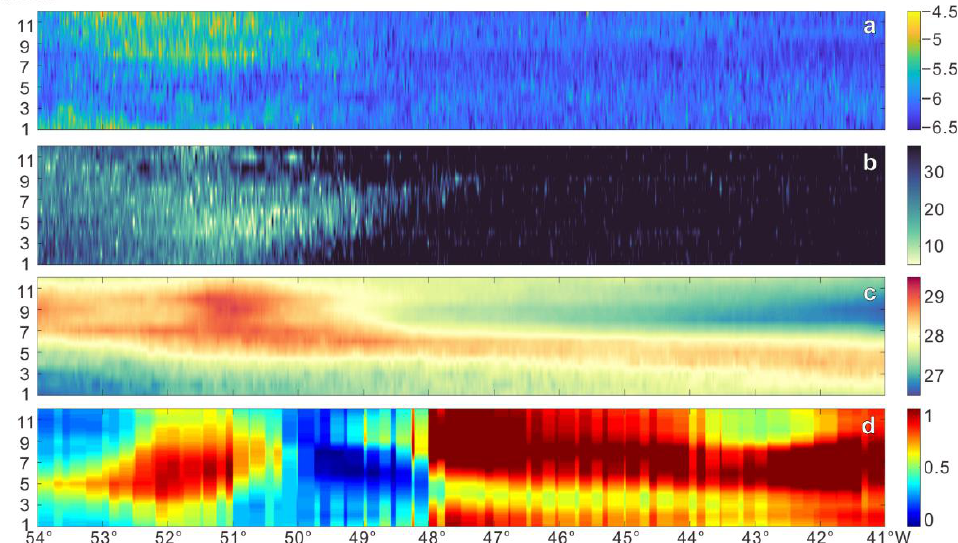
Figure 8. Ten-year averaged monthly variations of various elements along transect N. ( a ) Water remote-sensing reflectance (R rs , to represent the SPM; unit: lg(sr − 1 )); ( b ) sea surface salinity (SSS; unit: PSU); ( c ) sea surface temperature (SST; unit: °C); ( d ) ocean current velocity (unit: m/s). The ordinate is the month (January – December) and the abscissa is the longitude.